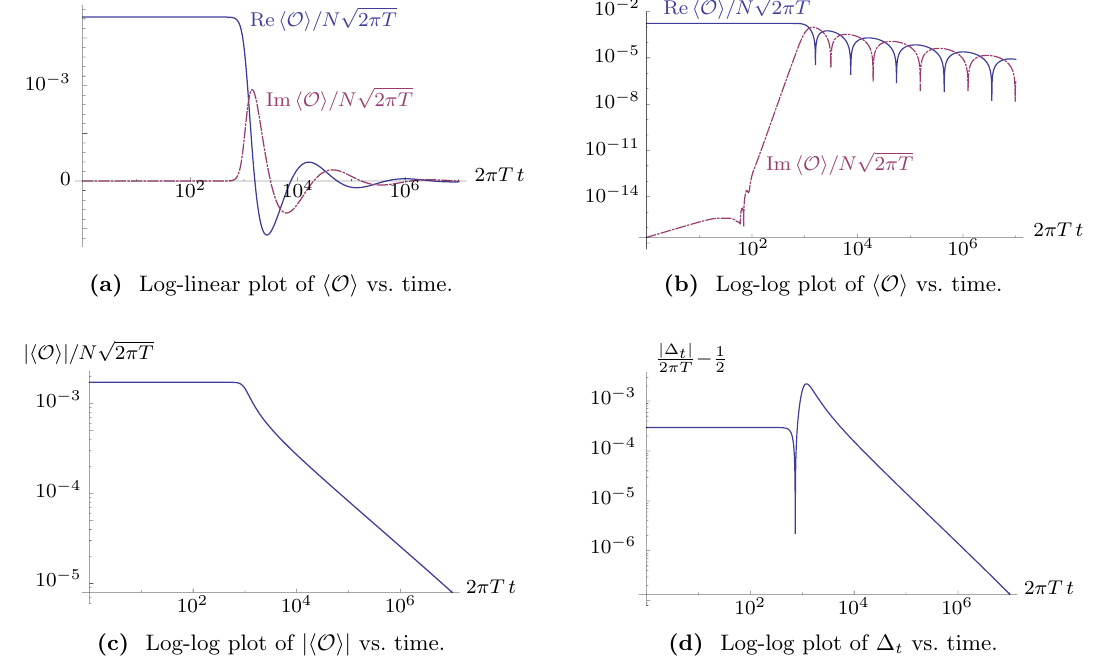
Figure 11. A log-linear (a) and log-log (b) plot of (cid:11) 1 and (cid:11) 2 as functions of time. Below, we see log-log plots of the gauge-invariant quantities (cid:1) t = (cid:22) (cid:0) @ 0 and (cid:12) = hOi =N which are not featuring any oscillations in (logarithmic)